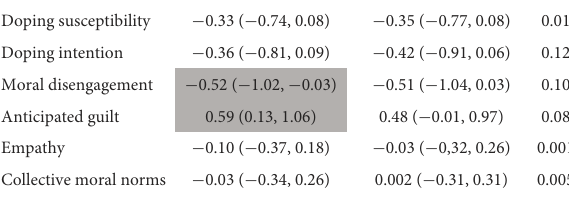
TABLE 3 Intervention effect for both interventions at posttest compared to control